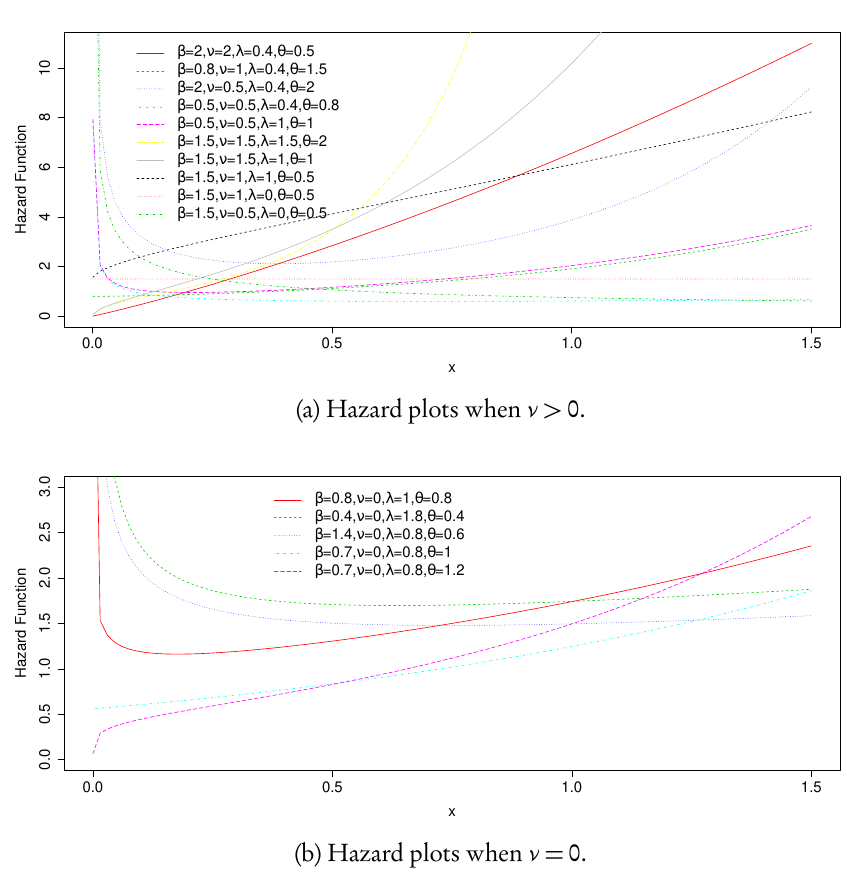
Figure 2 – The plots of hazard rate function of EMW